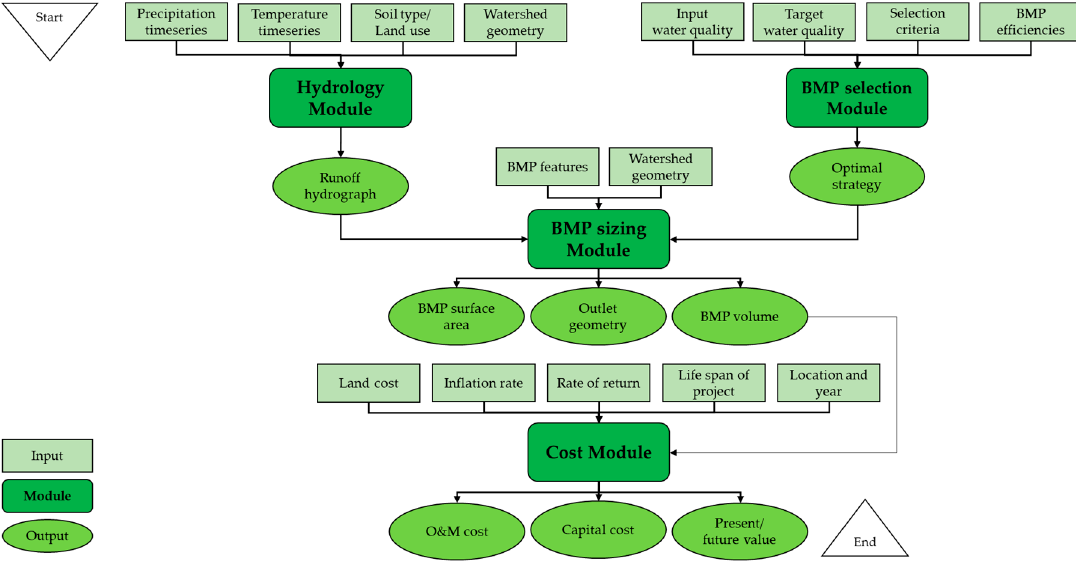
Figure A1. Flowchart describing i-DSTss